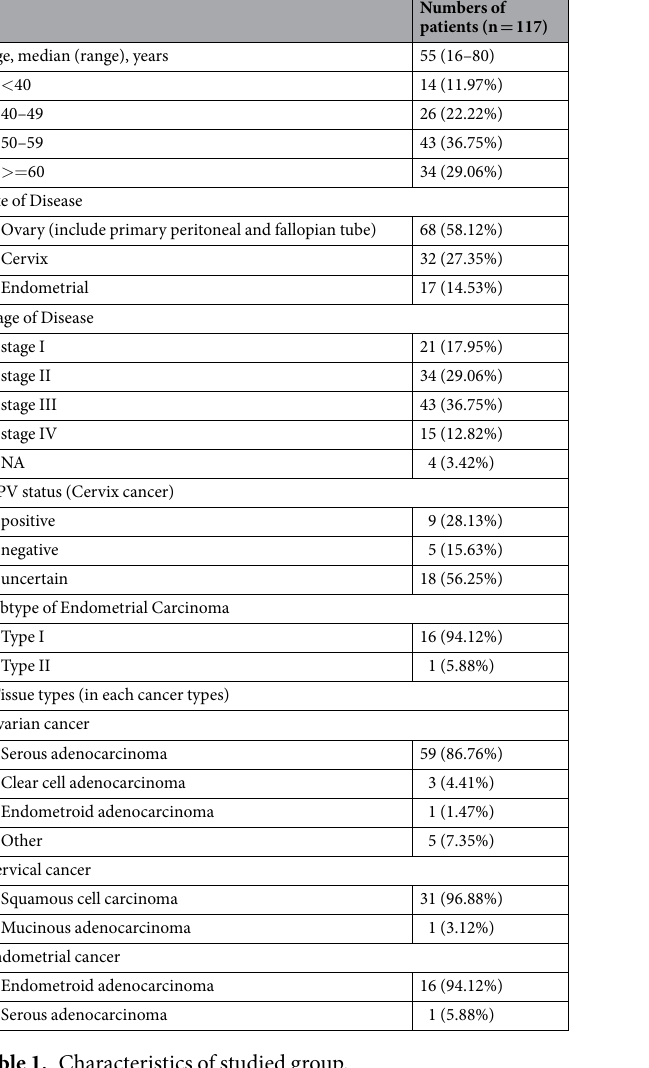
Table 1. Characteristics of studied